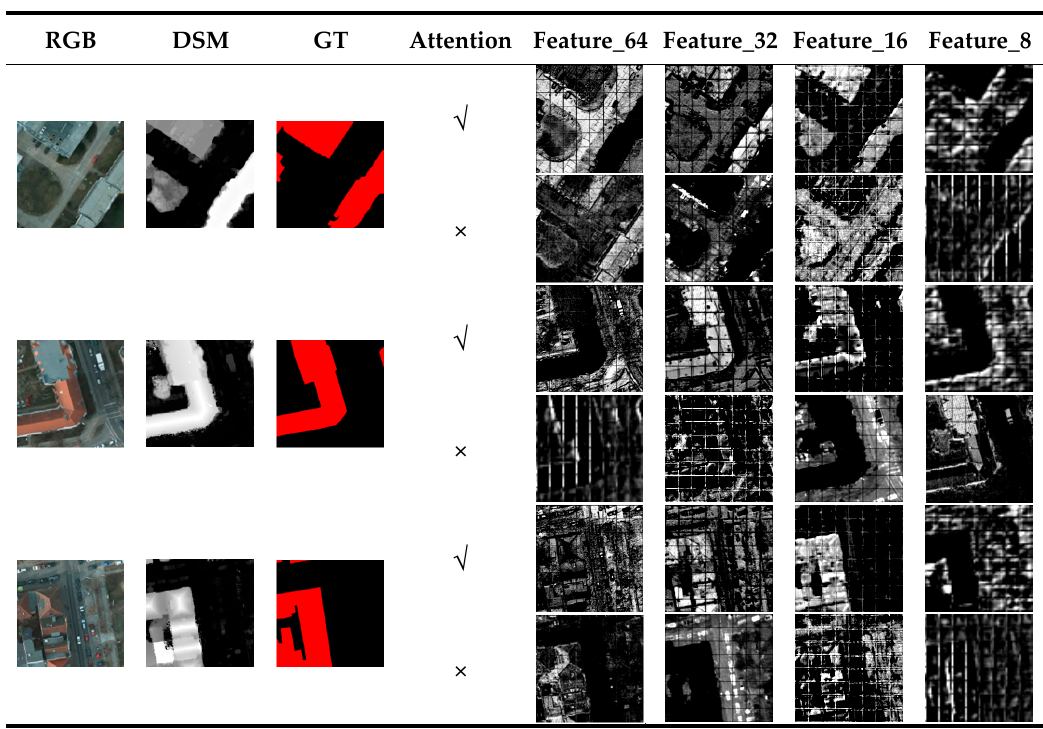
× Figure 7. Visualized cross-modal features in different layers with/without an attention module. Figure 7. Visualized cross-modal features in di ff erent layers with / without an attention module. Table 4. Quantitative results of fusion networks with/without an attention module.